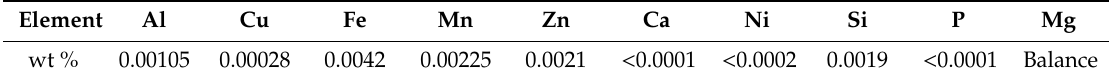
Table 1. Chemical composition of Mg determined by spark